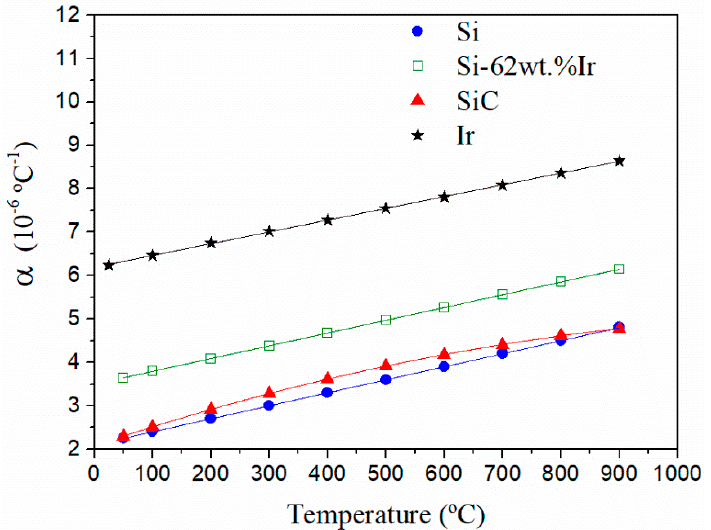
Figure 5. Evolution of thermal expansion coefficients, from 25 °C to 900 °C of pure silicon and Si-62 wt% Ir alloy experimentally measured, and SiC [31] and Ir [30], taken from bibliographical references.